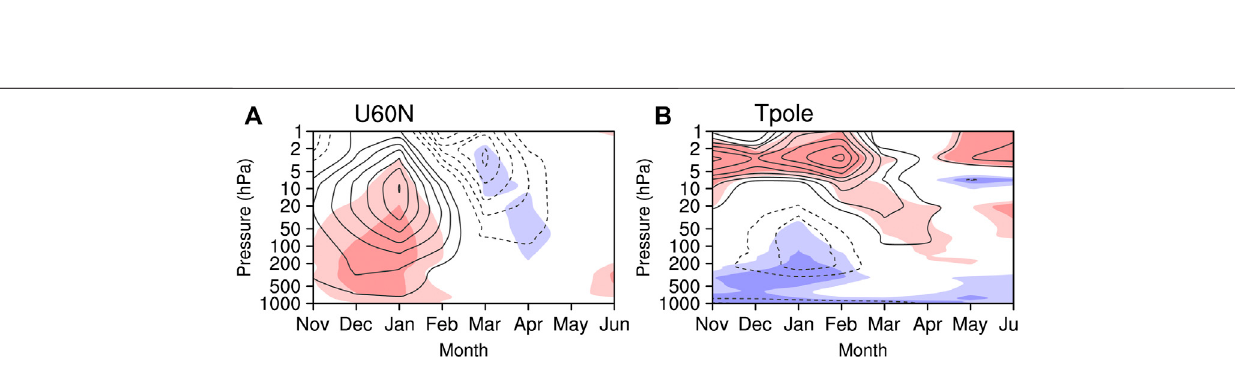
Frontiers in Earth Science |